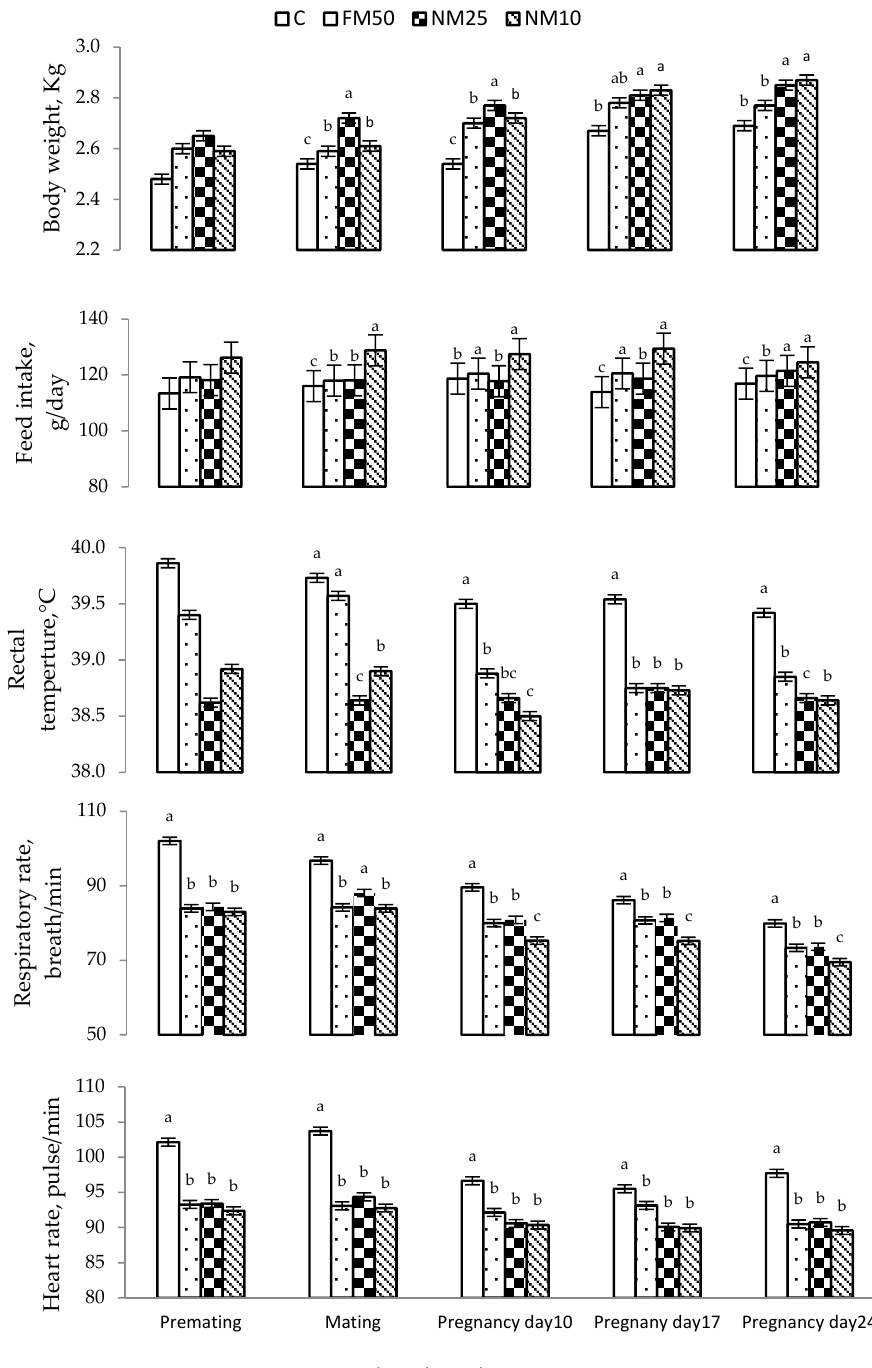
Figure 1. Mean ( ± SEM) treatment by physiological status effects on bodyweight, feed intake, rectal temperature, the respiratory rate and the heart rate of female rabbits. C = 0 mg/kg BW MLEE, FM 50 = 50 mg/kg BW MLEE, NM 25 = 25 mg/kg BW nanoencapsulated MLEE and NM 10 = 10 mg/kg BW nanoencapsulated MLEE. Means within the same physiological status having different superscripts (a, b, c) differ significantly ( p < 0.05). The effects of different treatments (C = 0 mg/kg BW MLEE, FM 50 = 50 mg/kg BW MLEE, NM 10 = 10 mg/kg BW nanoencapsulated MLEE and NM 25 = 25 mg/kg BW nanoen- capsulated MLEE) on the blood plasma of female rabbits during the experimental